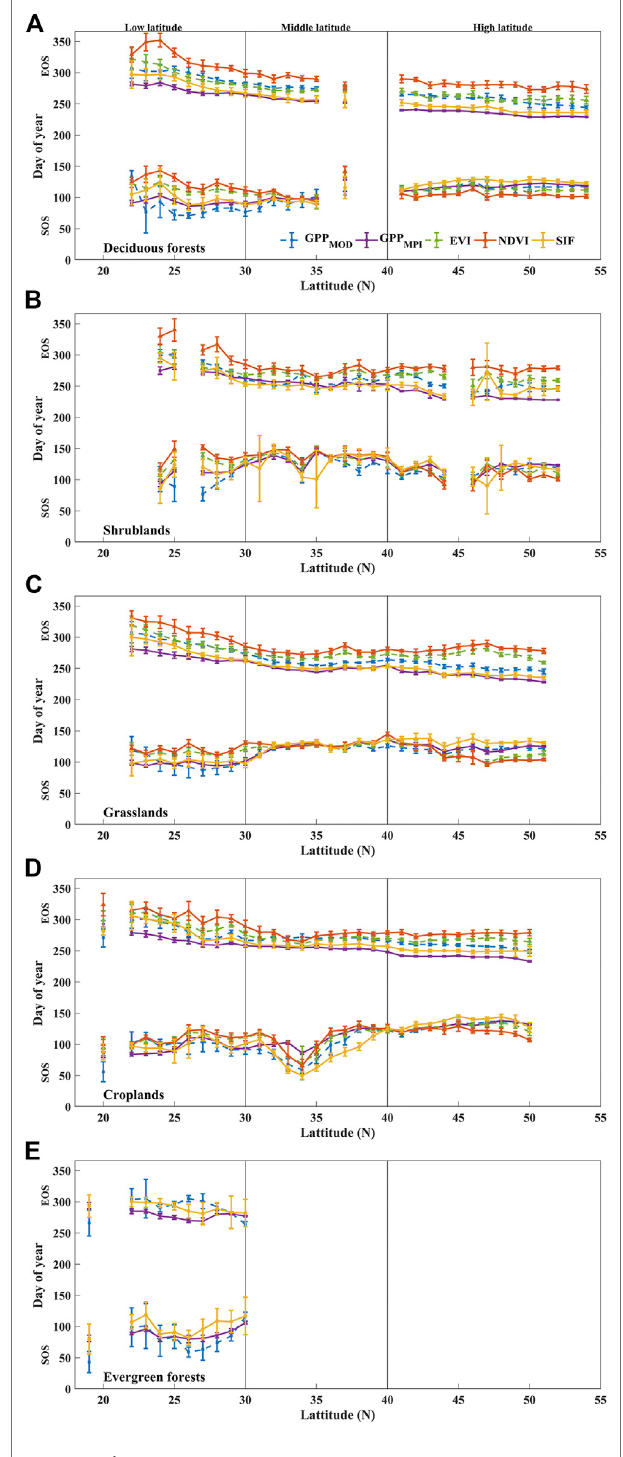
FIGURE 9 | The area-averaged SOS (the lower lines) and EOS (the upper lines) of GPP MOD , GPP MPI , NDVI, EVI, and SIF over deciduous forests (A) , shrublands (B) , grasslands (C) , croplands (D) , and evergreen forests (E) during 2007 – 2013 in China. The points and error bars in all subplots represent the mean and standard deviations for 2007 – 2013,